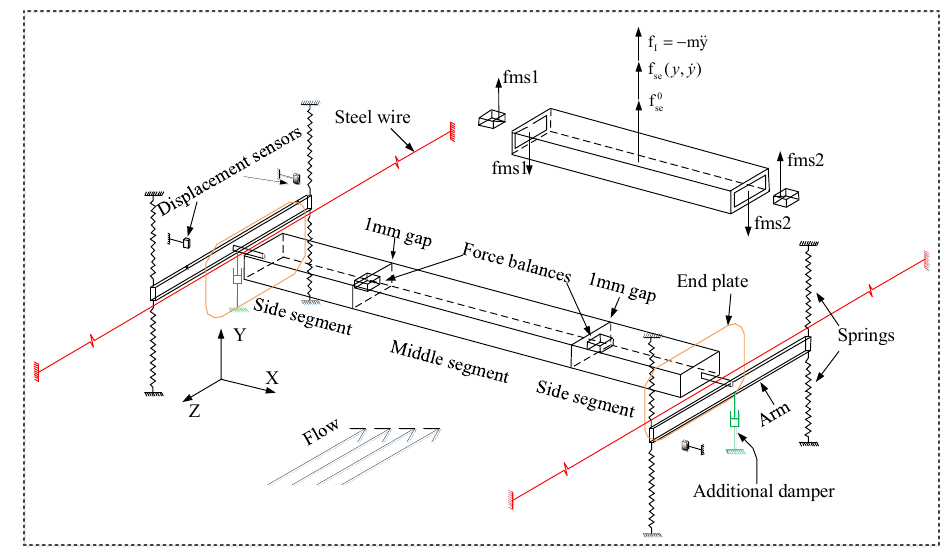
Figure 7. A spring-suspended system that is used for based force and response measurements [41,44].